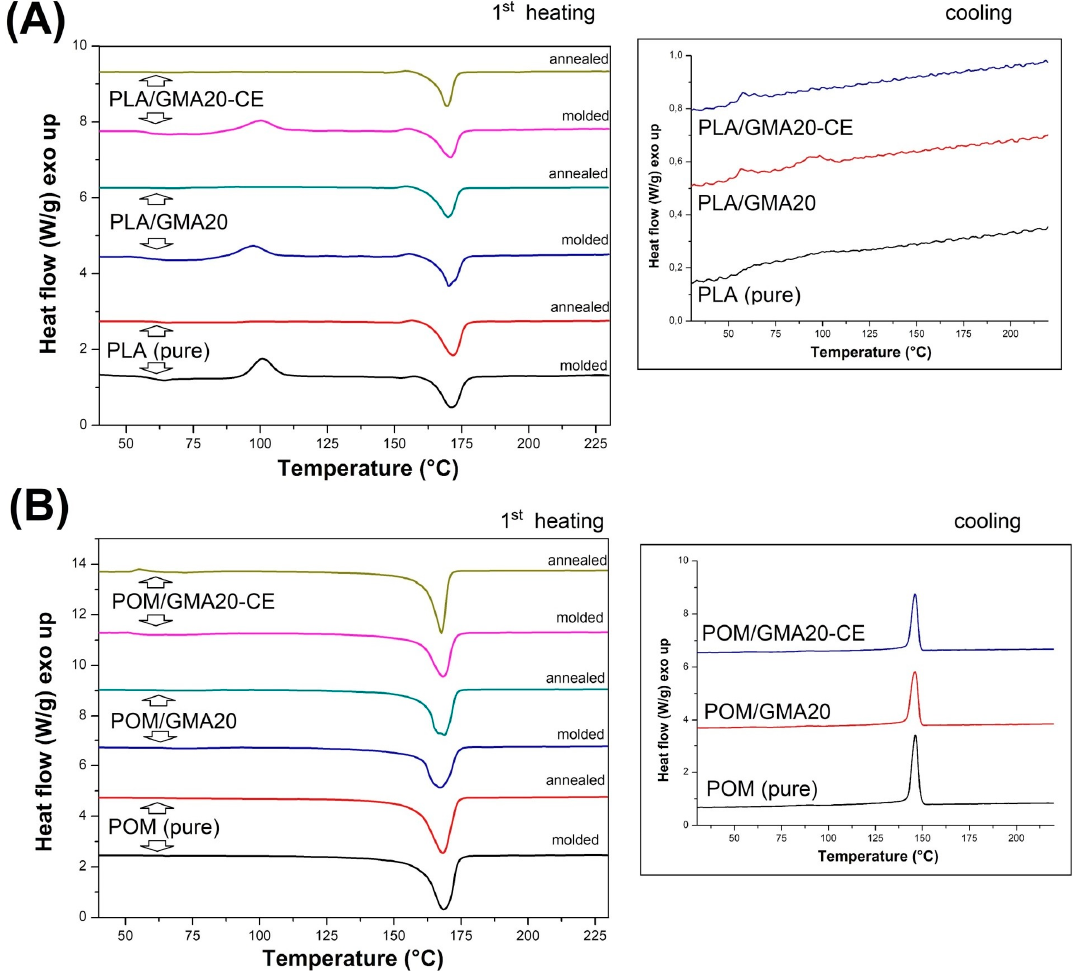
Figure 13. First heating and cooling for ( A ) PLA- and ( B ) POM-based blends. Table 2. Basic thermal properties of the prepared materials for the as-molded and annealed samples.